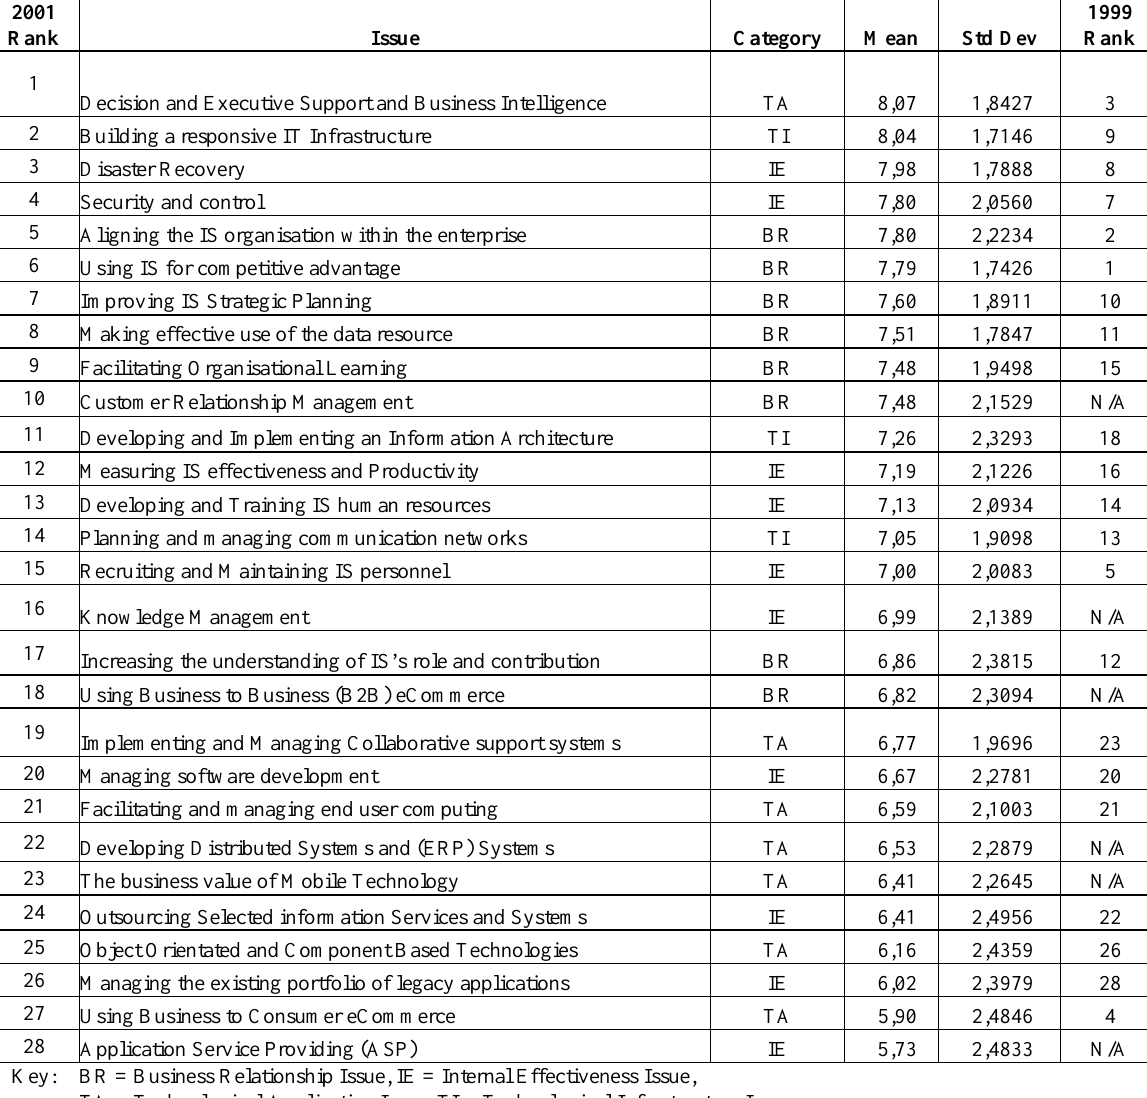
Table 2: 2001 Ranked key issues